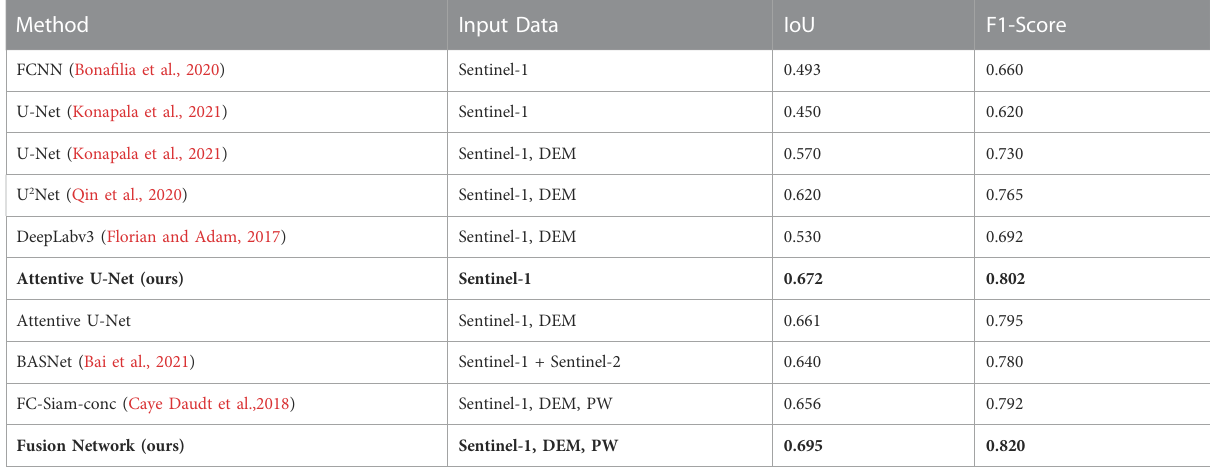
TABLE 1 Quantitative Comparison: Comparison of our Attentive U-Net and Fusion Network method with existing methods. The comparison is made in terms of average IoU and F1 score on test dataset. The best results and corresponding models are highlighted in bold.